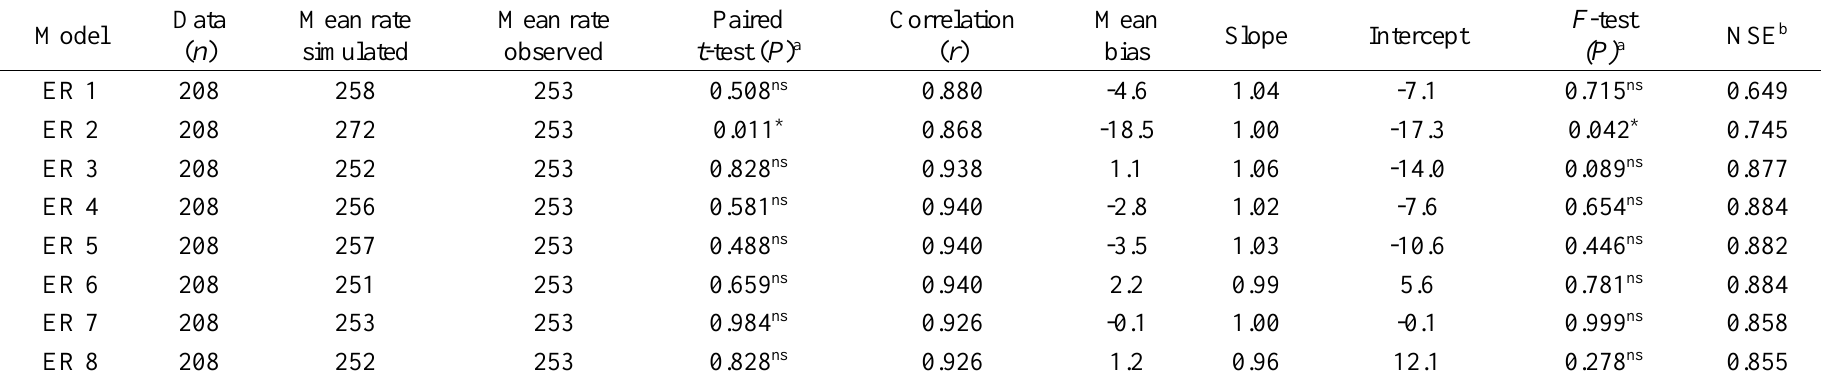
Table A2. Model performance statistics for ecosystem respiration (ER) models fitted to data from semi-flooded (S-F) treatments.